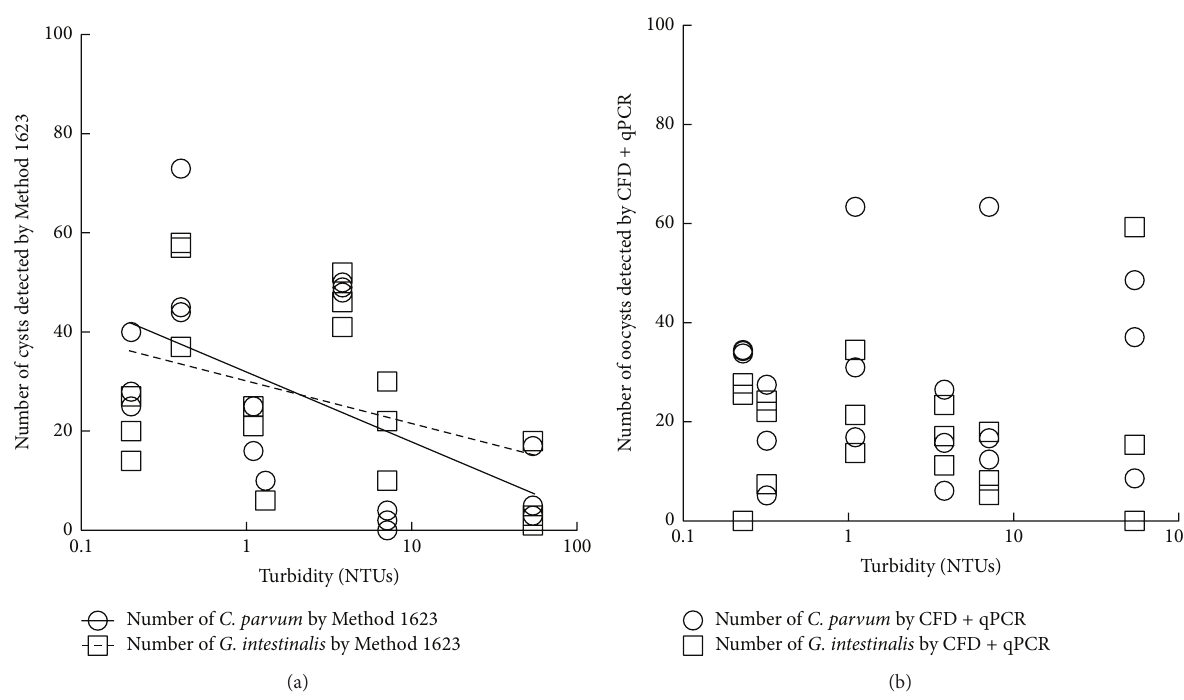
Figure 3: The effect of increasing turbidity in samples on the performance of Method 1623 (a) and the CFD + qPCR method (b) for both Giardia intestinalis and Cryptosporidium